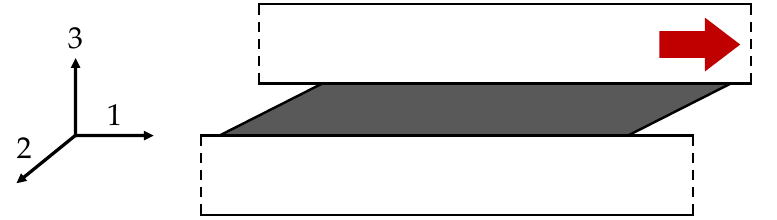
Figure 3. Sliding plate rheometer and defined coordinate system.